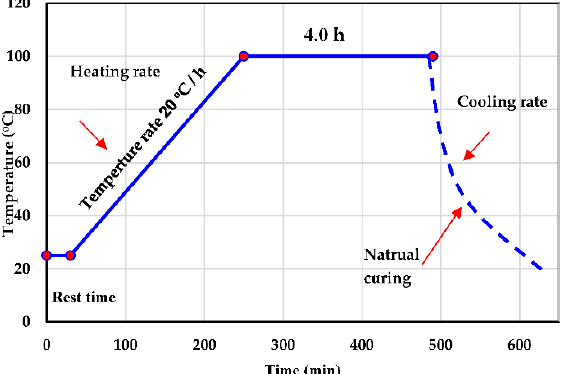
Table 2. The parameters used for control of early compressive strength development.